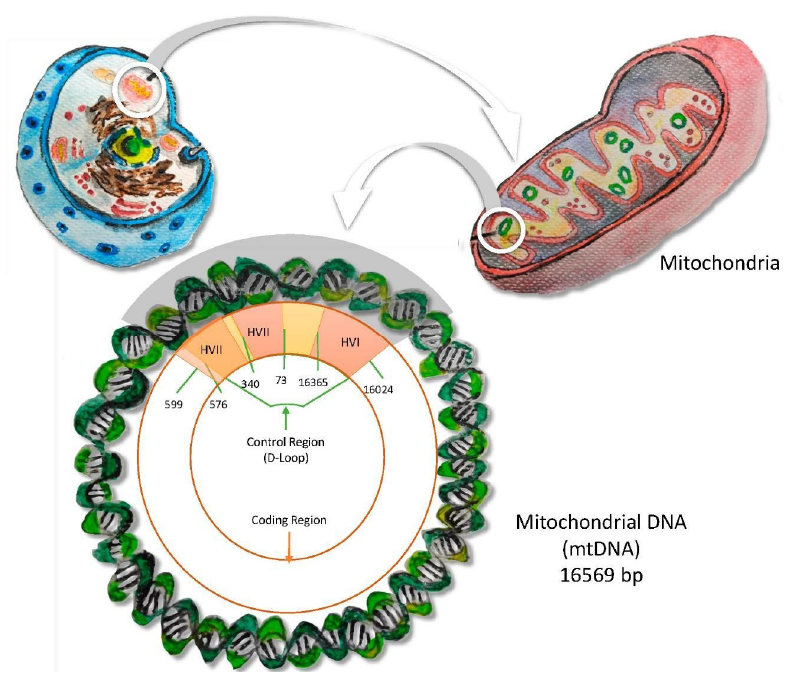
Figure 4. mtDNA location and structure.